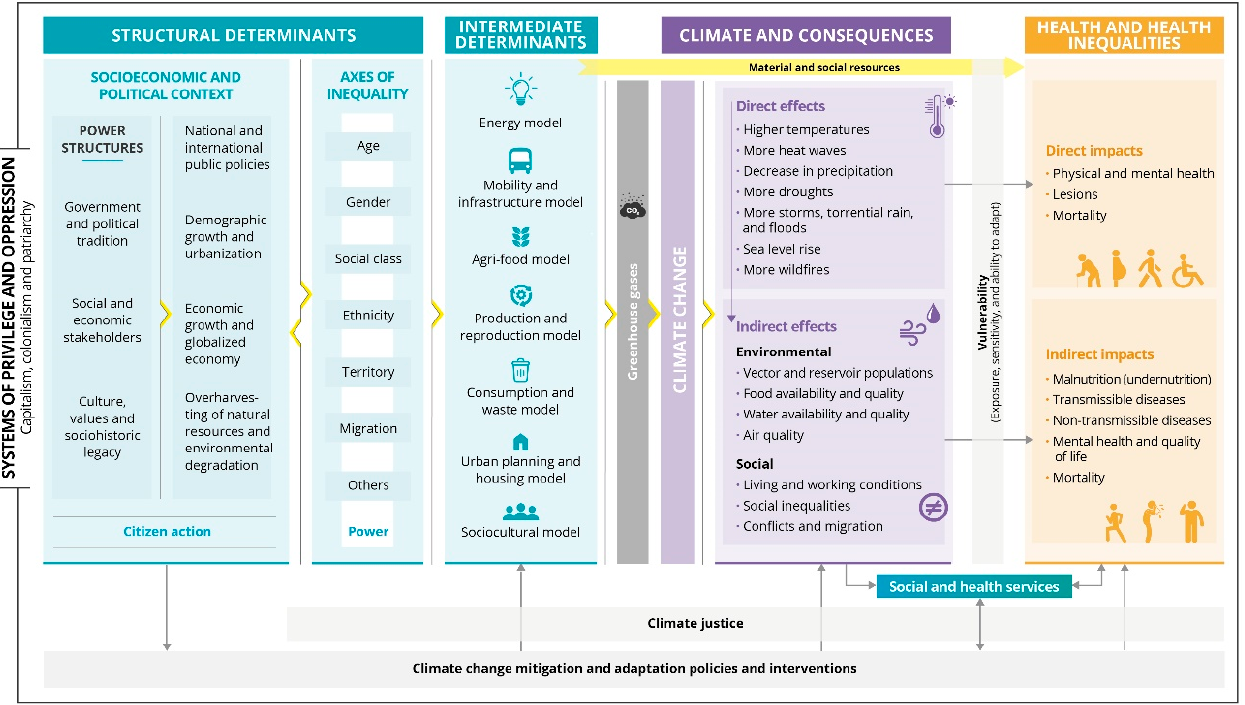
Figure 1. Conceptual framework of the determinants of climate change, its environmental and social consequences, and its effects on health and health inequalities, for urban contexts with a Mediterra- nean climate and from a social and climate justice